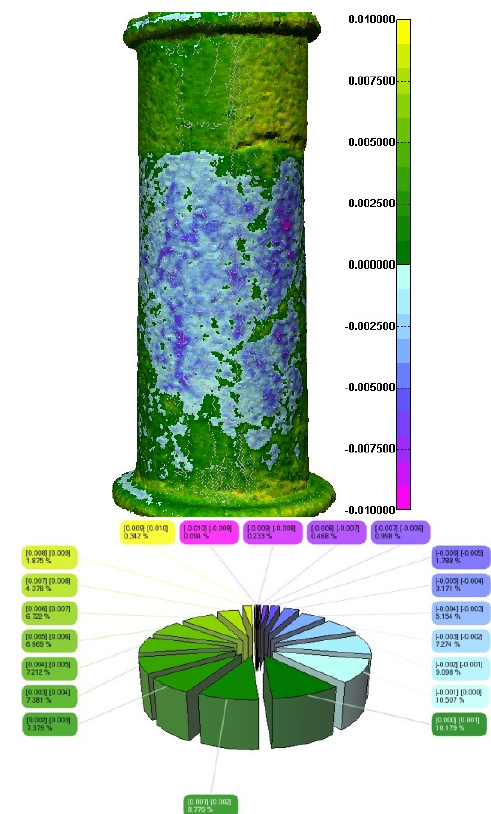
Figure 9. Error-map color mode and pie-type error distribution chart for subproject 5.